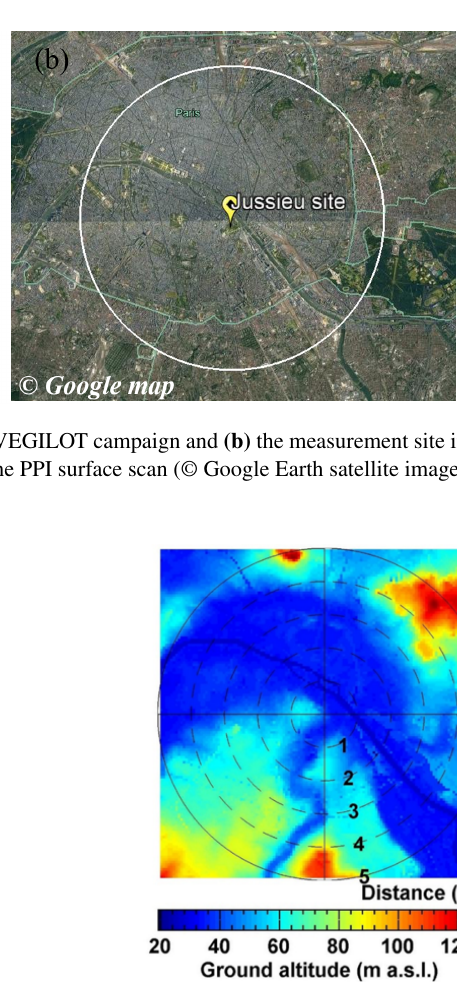
Figure 2. Ground altitude map above sea level with 75m spatial resolution for the scanning area in Paris (credit: Institut National de l’Information Géographique et Forestière, https://www.data.gouv. fr/fr/datasets/bd-alti-r-75-m-250-m-1-000-m/, last access: 2